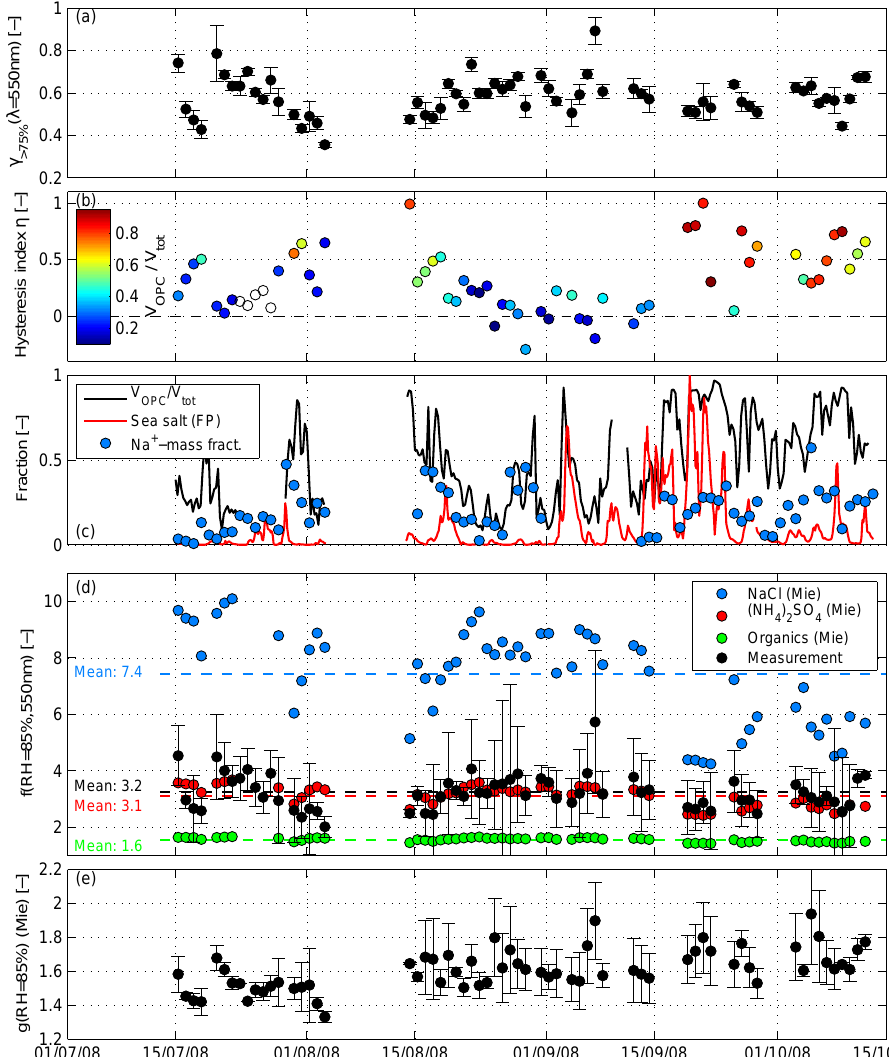
Fig. 7. (a) : Time series of fit-parameter γ > 75% , error bars indicate the 95% confidence level. (b) : Hysteresis index η , color code indicates the volume fraction of large particles ( V OPC /V tot ). (c) : Measured volume fraction of large particles V OPC /V tot (black line), normalized sea salt number concentration for the 1–10µm particle diameter size range as derived from FLEXPART analysis (red line) and measured Na + -mass fraction (blue points). (d) : Calculated f ( RH = 85%, λ = 550nm) using the measured size distribution and assuming a constant chemistry (constant hygroscopic growth and complex refractive index) and measurement of f ( RH = 85%, λ = 550nm) (black circles, error bars are standard deviation of daily median values). (e) : Retrieved growth factor ( g( RH = 85% ) ). See retrieval scheme in Fig. 1. Data is only shown for periods with available WetNeph